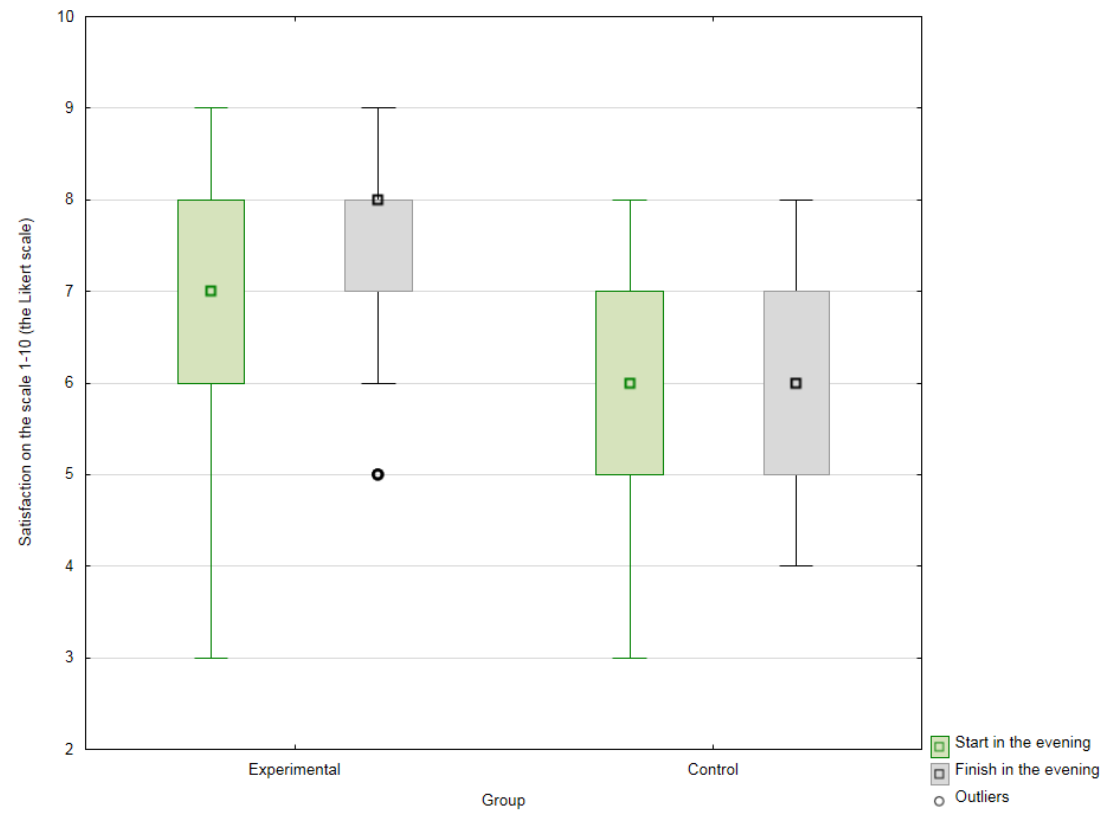
Figure 2. Differences between values at the end of therapy sessions with the dog, at the start of the 15-week cycle of therapy and the end, for the experimental group; values for the control group at hourly intervals from the morning, at the start and end of the 15-week research cycle.